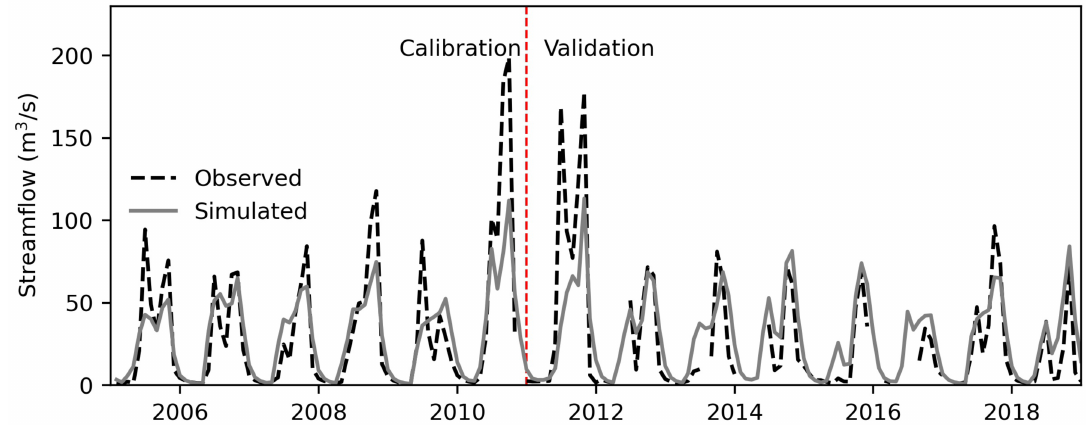
Figure 3. Monthly calibration and validation for streamflow at Osicala